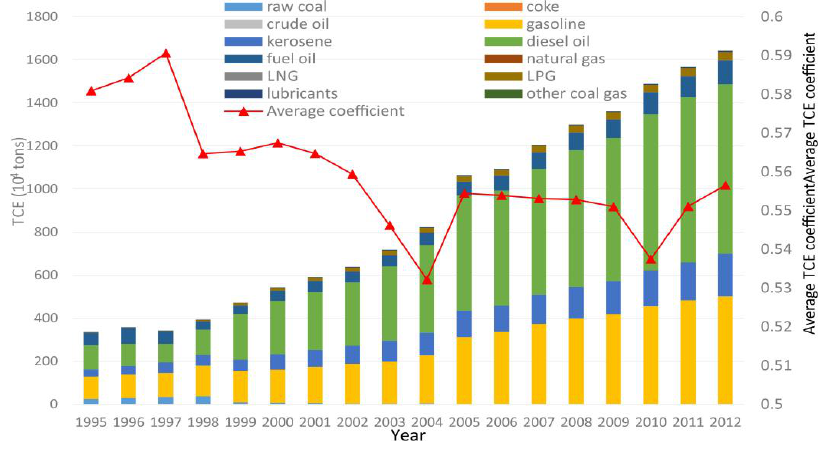
Figure 3. Average TCE coefficient and TCE structure of different energy types.